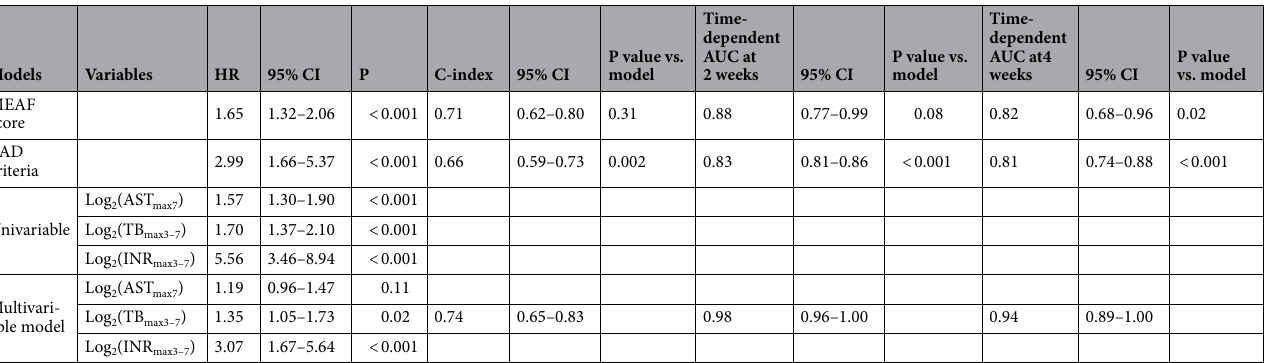
Table 3. Comparisons of C-index, time-dependent AUC at 2 weeks, and time-dependent AUC at 4 weeks between Cox proportional hazard regression models using MEAF score, EAD criteria and newly developed